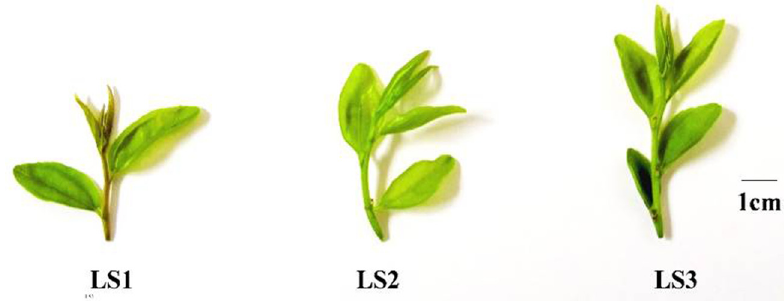
Figure 1: Three di ff erent foliar ages of jujube leaves. LS1 and LS2 represented one bud with two leaves and there leaves, respectively, and LS3 represented one bud with four leaves. Developmental stages, LS1 – LS3, corresponded to days of 20, 27, and 35 after germination, respectively. Bar size = 1